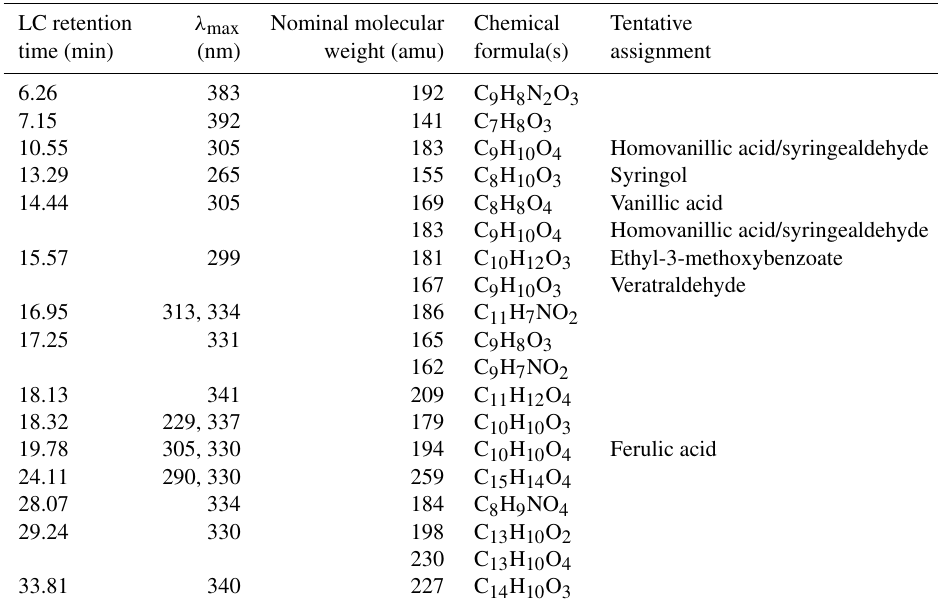
Table 3. The list of retention times, absorption peak maxima, and chemical formulas of the BrC chromophores detected in the brushwood smoke sample. Tentative assignments are given based on compounds previously identified in the lignin pyrolysis literature.